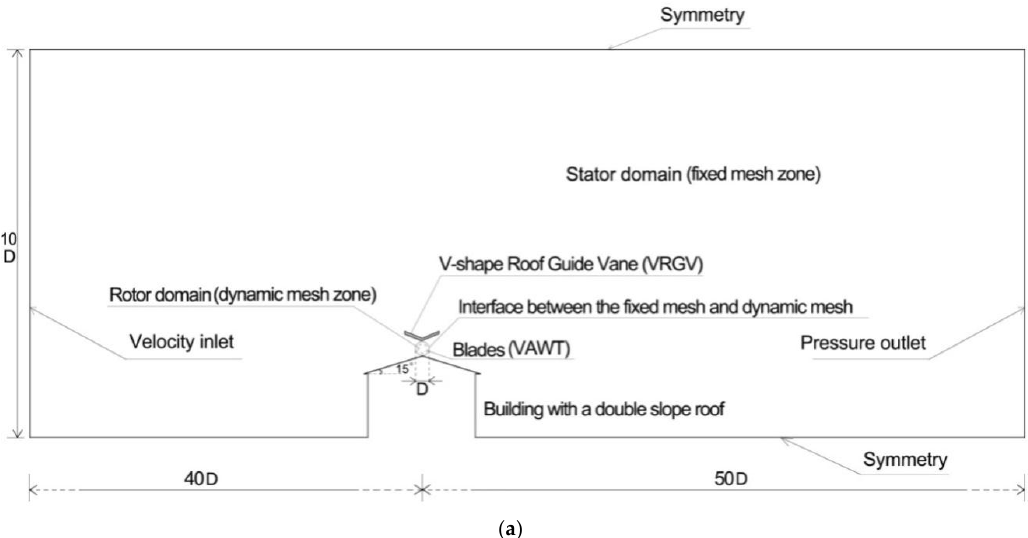
Figure 14. Comparison of C p for different turbulence model versus azimuthal angles for a complete revolution. Reprint with permission [61]; 2018, Elsevier.